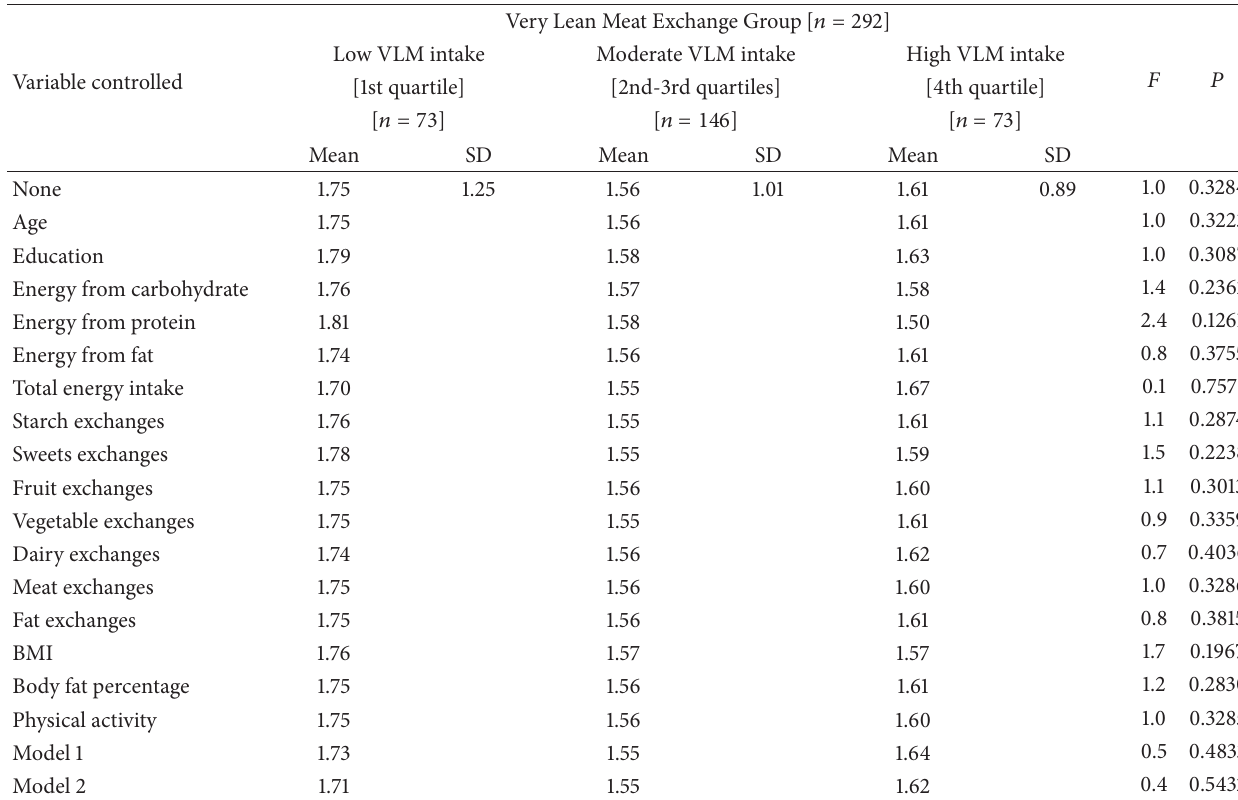
Table 3: Mean differences in insulin resistance [HOMA] across the very lean meat [VLM] category, without and with means adjusted for the potential